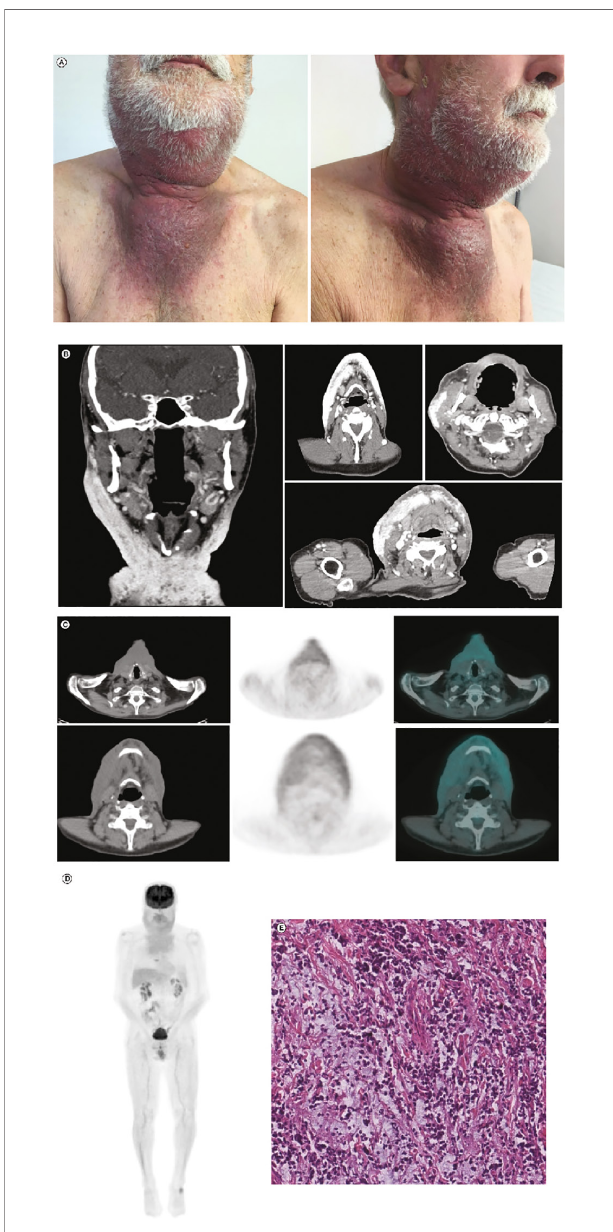
FIGURE 2 | Post-ECT restaging: (A) Post-ECT clinical presentation with an extensive, dark lesion (approximately 8.5 × 10.0 cm) in the preauricular and laterocervical regions. (B) Coronal (leftmost panel) and axial (right panels) CT scans showing extensive in fi ltrates in the subcutaneous tissues of the bilateral laterocervical region and right preauricular area. (C) Left to right: CT scan, FDG- PET scan, and CT and FDG-PET fusion images showing pathological accumulation in the preauricular area extending until the bilateral laterocervical and sternal level. (D) Total-body FDG-PET image con fi rming signi fi cant FDG uptake in mandibular, laterocervical, and sternal regions. (E) Hematoxylin and eosin stain (scale bar: 50 µm) of the tumor sample taken after ECT. Compared with the tumor sample collected before ECT, there was a decrease in neoplastic cellularity and edematous stroma. CT, computed tomography; ECT, electrochemotherapy; FDG-PET, 18- fl uorodesossyglucose-positron emission tomography; MCC, Merkel cell